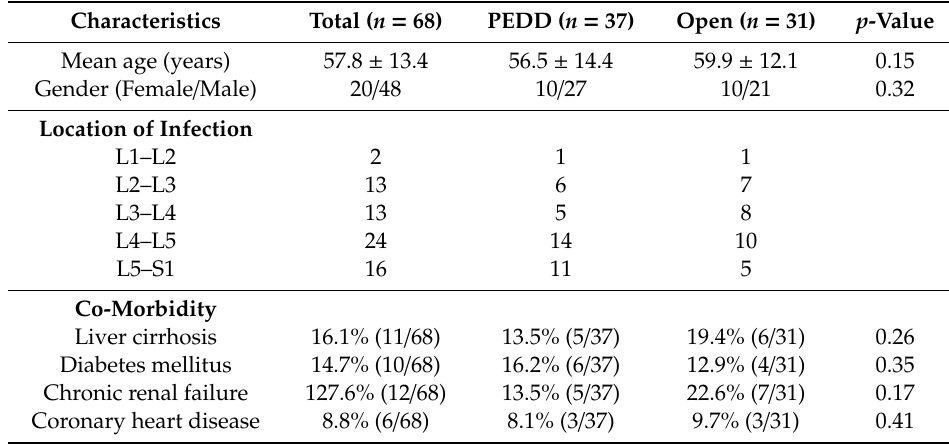
Table 1. Patients’ characteristics.